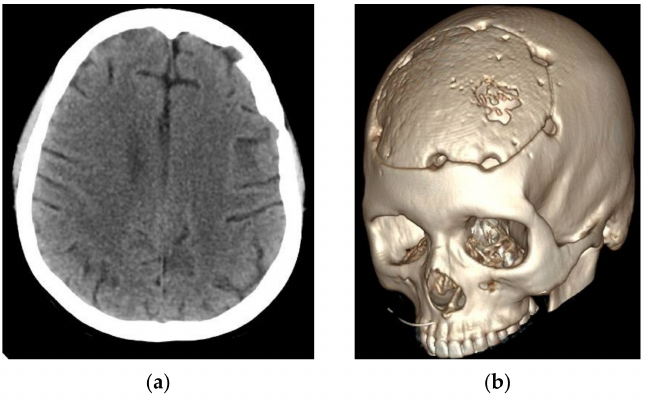
Figure 11. Twelve months follow-up CT Scan. ( a ) axial—very good left frontal lobe recovery. ( b ) 3D